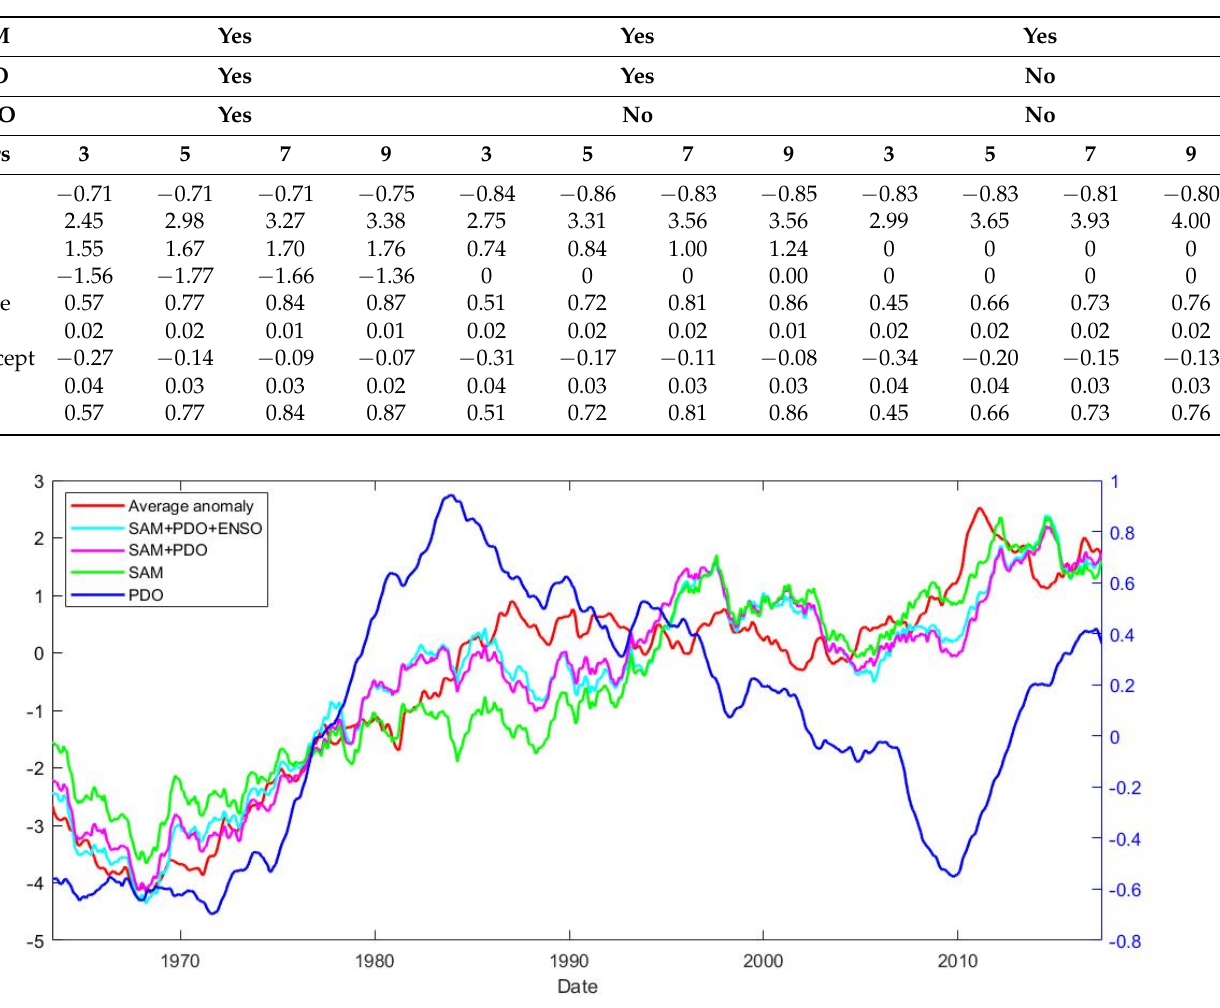
Table 2. Results of the adjustment of Equation (2) to the ERA5 data. The indicators (slope, vertical intercept, and R 2 ) of the quality of this adjustment can be compared to those obtained when not taking into account the ENSO (c is forced to 0), or both the PDO and the ENSO (b = c = 0). The standard deviations (sd) of the slope and vertical intercept correspond to the 95% confidence interval.